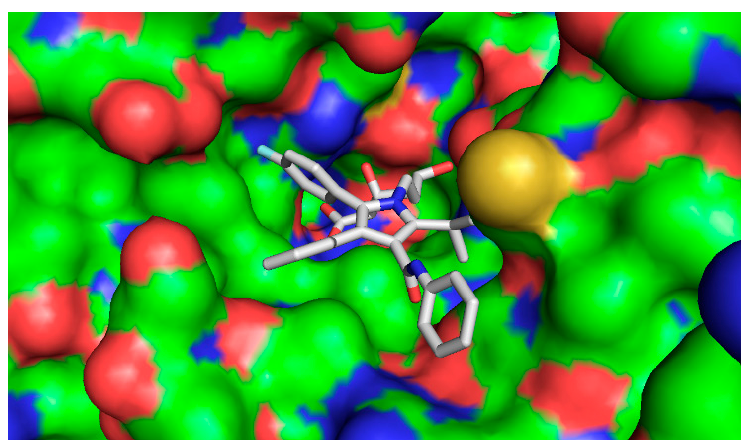
Figure 11. Bound conformer of ligands interacting with the substrate binding sites of HMGR for Leucodin (CP2).